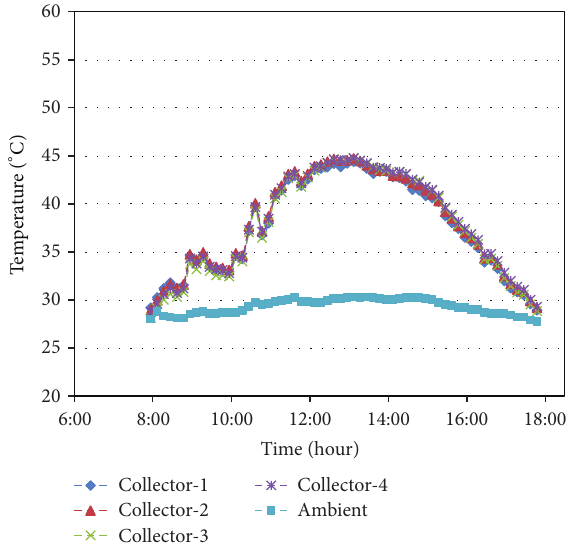
Figure 2: Temperature profile of collector with similar glazing